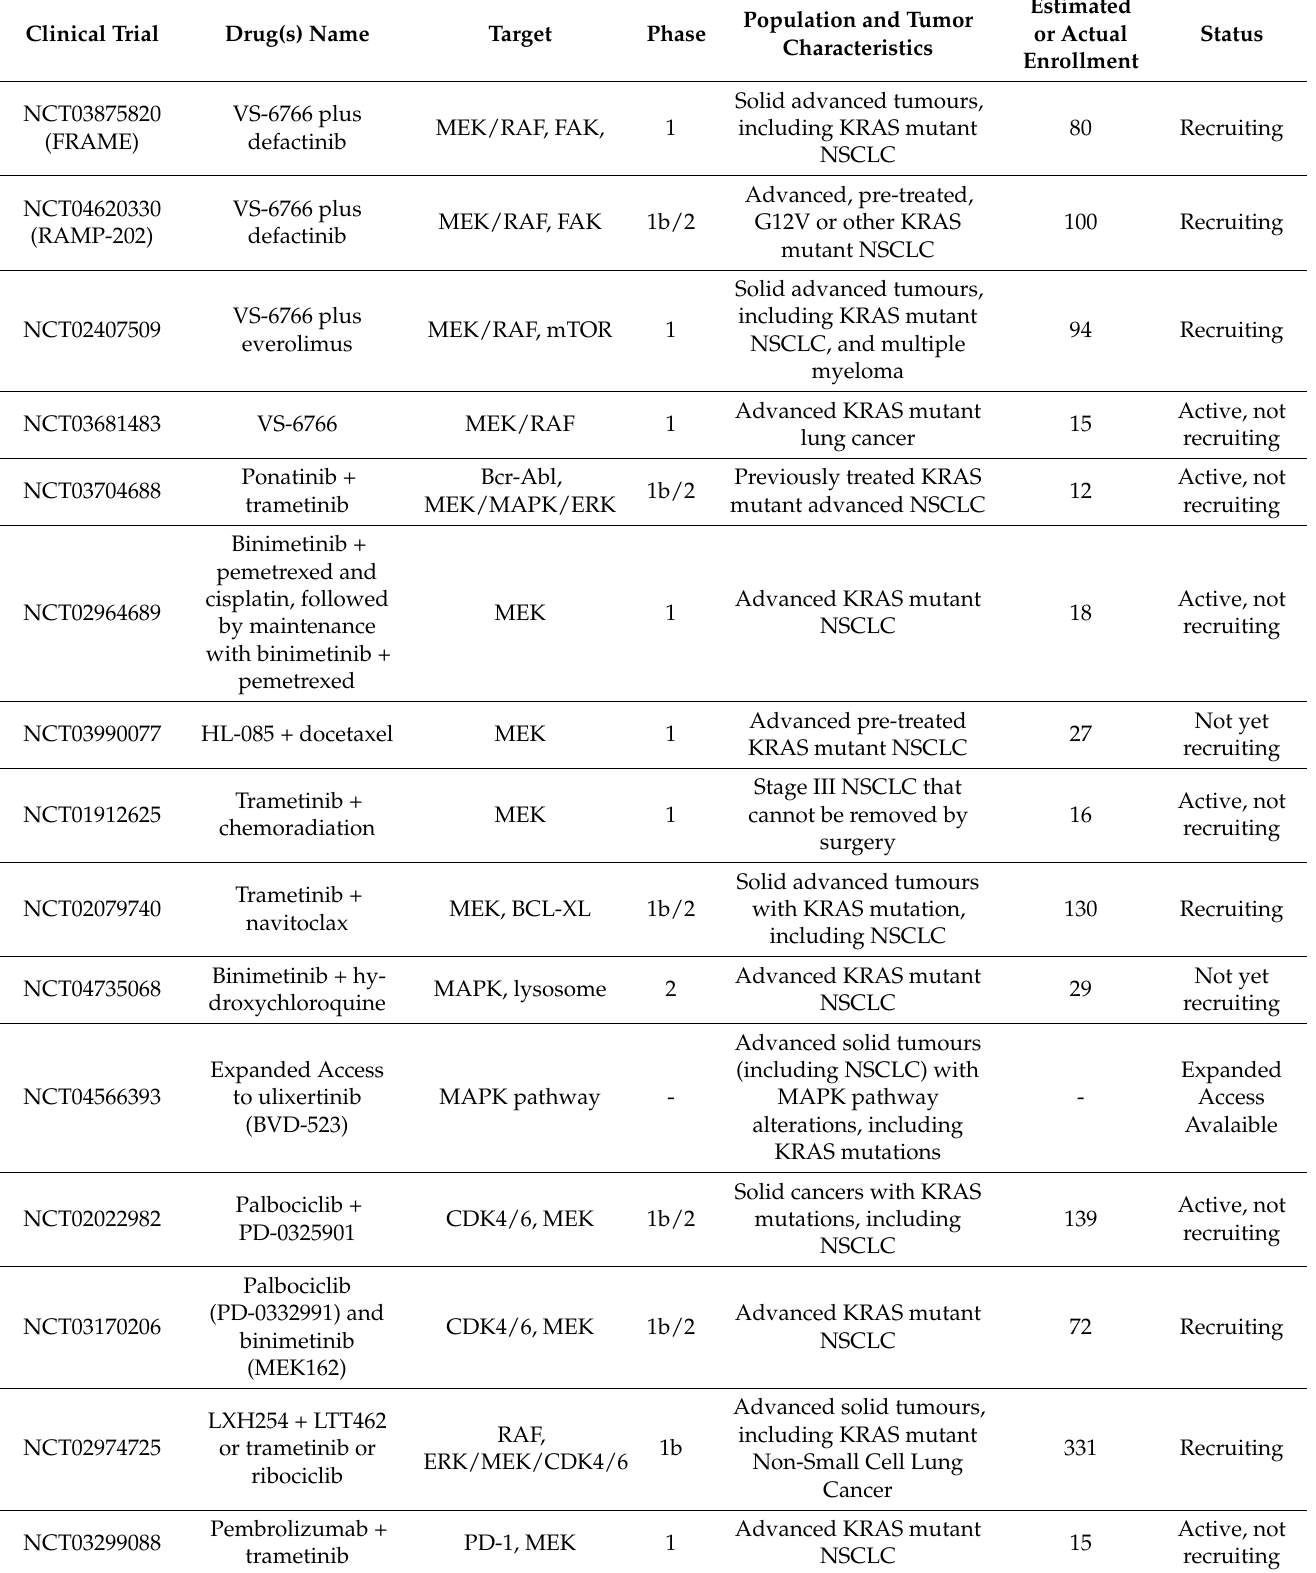
Table 3. Which options for “non-G12C” KRAS patients? Main ongoing clinical trials (clinicaltrials.gov (accessed on 20 July